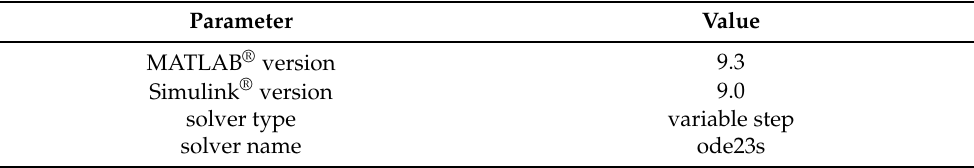
Table 1. Simulation parameter.